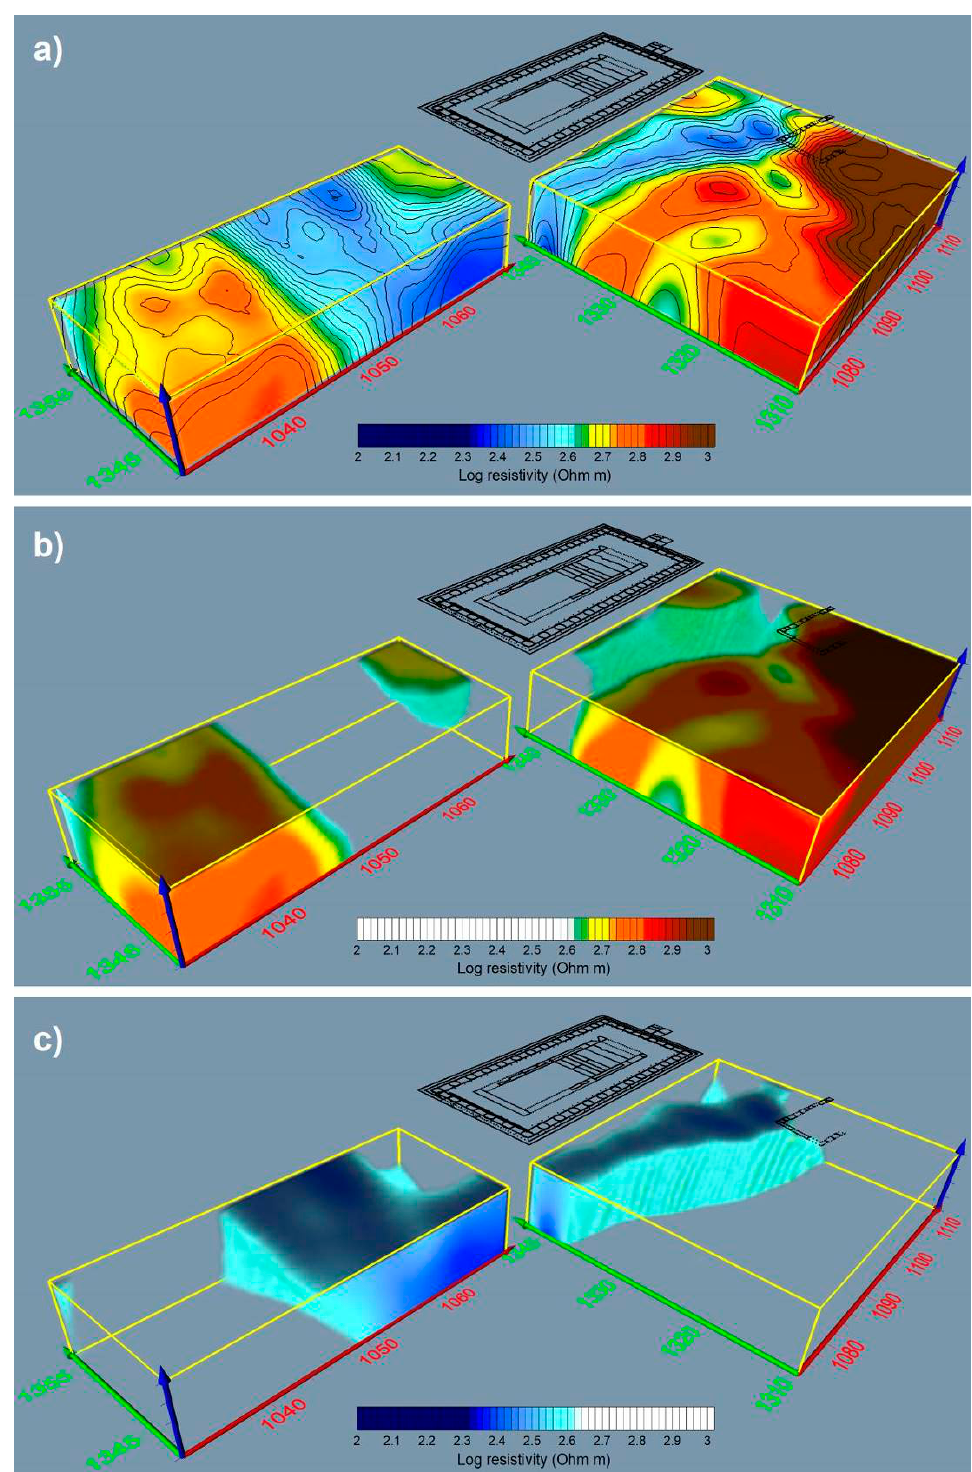
Figure 11. Three-dimensional view of the probability-based ERT ( a ) and representations limited to the anomalies including values greater ( b ) or lower ( c ) than 398 Ω m.